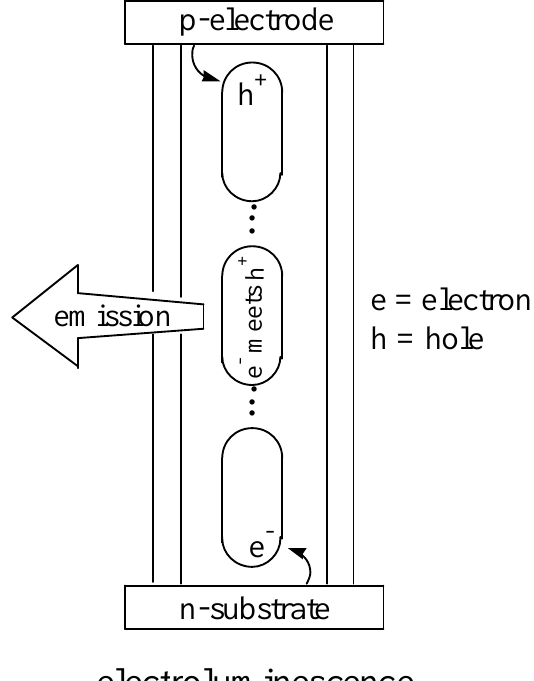
Figure 11: Schematic drawing of the electroluminescent properties which may arise when confining guest molecules within parallel channels of a porous host